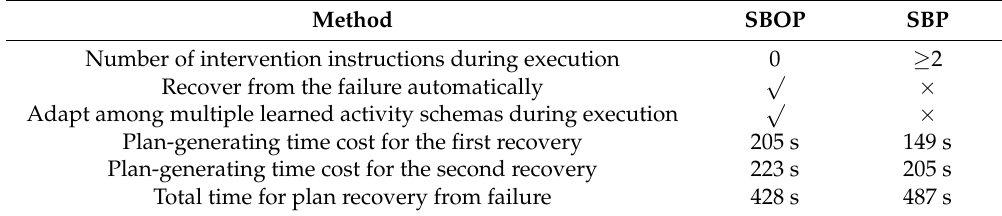
Table 1. Planners’ performance in serve_a_coffee